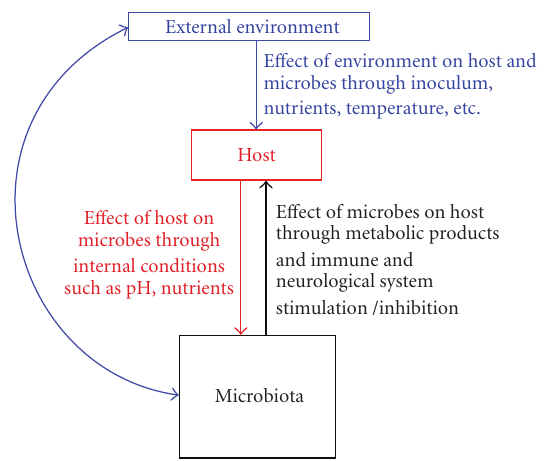
Figure 2: Potential mechanisms of interactions between external environment, host and the microbiota in the multicelled organ conceptualization of human